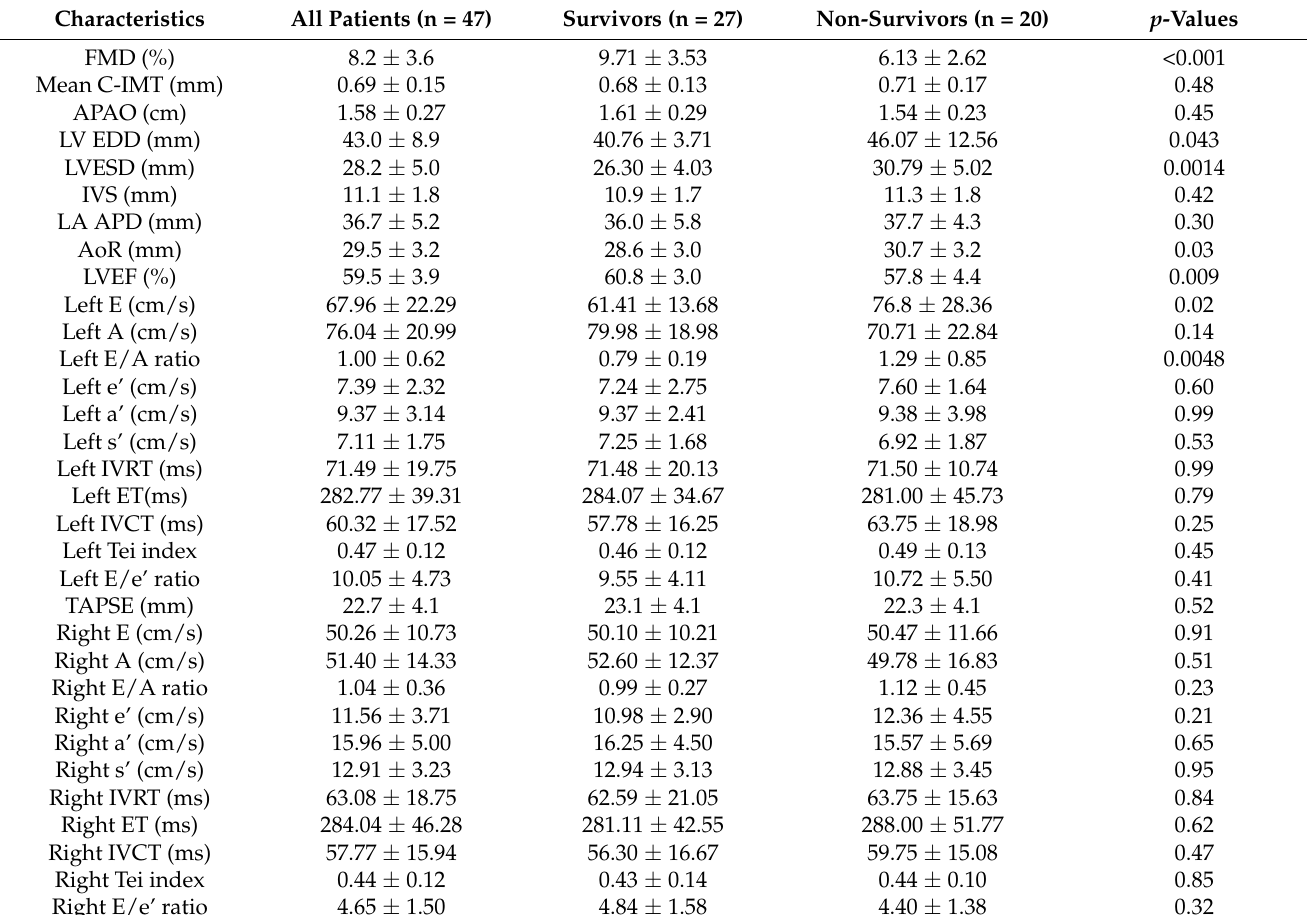
Table 2. Echocardiographic and vascular parameters showing comparisons between surviving and non-surviving patients.